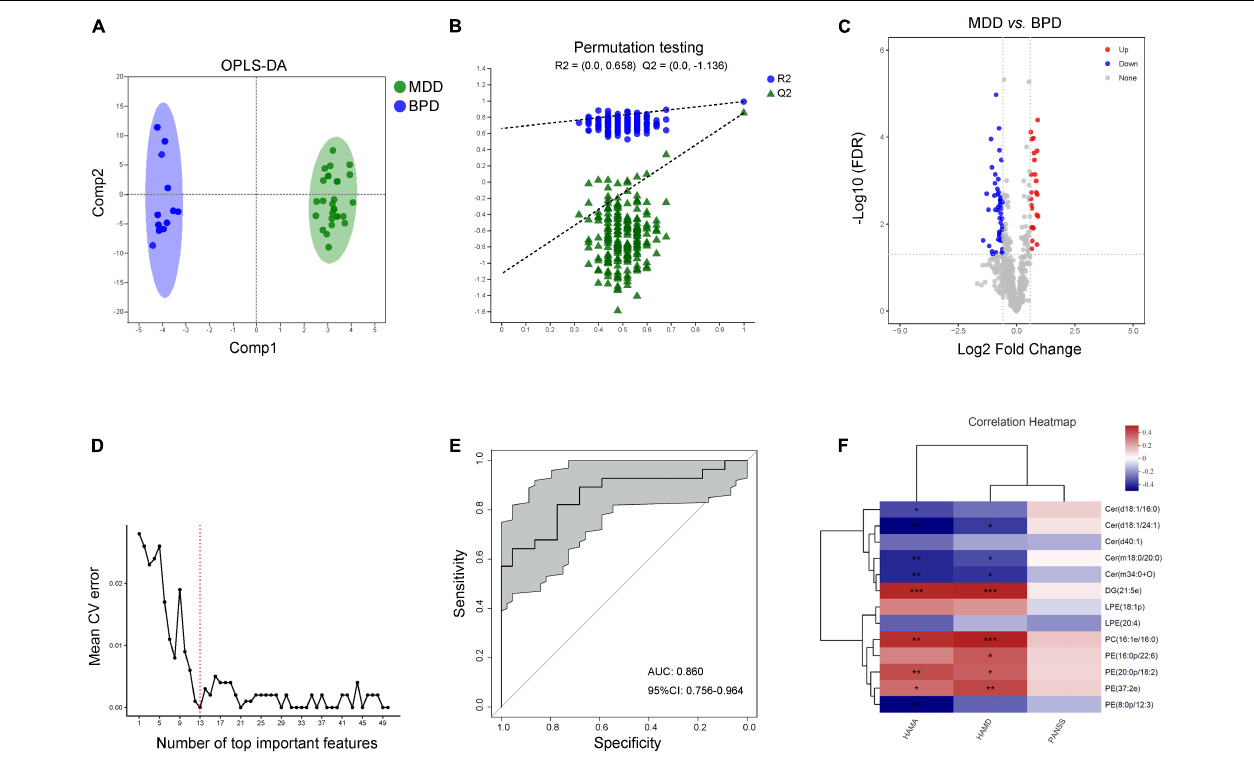
FIGURE 5 | Characteristic lipid species between MDD and BPD. (A) Scatter plot of OPLS-DA model and (B) validation model of permutation test, (C) volcano map reveals the increased (red dots) and decreased (blue dots) lipid species between the MDD and BPD, (D) random forest model and 10-fold cross-validation showed that the lipids with the top 13 importance had the lowest model error rate, (E) ROC analysis for the combinational lipids, (F) correlation between clinical parameters and levels of 13 lipid species. * P < 0.05; ** P < 0.01, *** P <